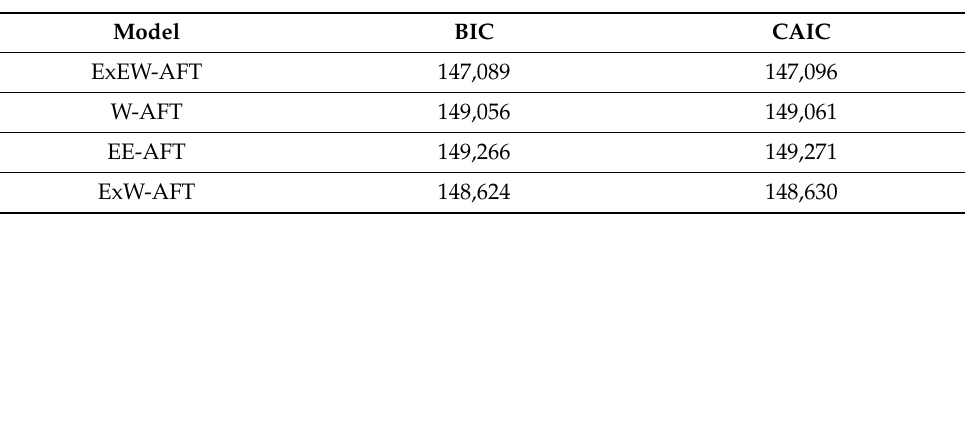
Table 23. The analytical performance measures for comparing AFT models for COVID-19